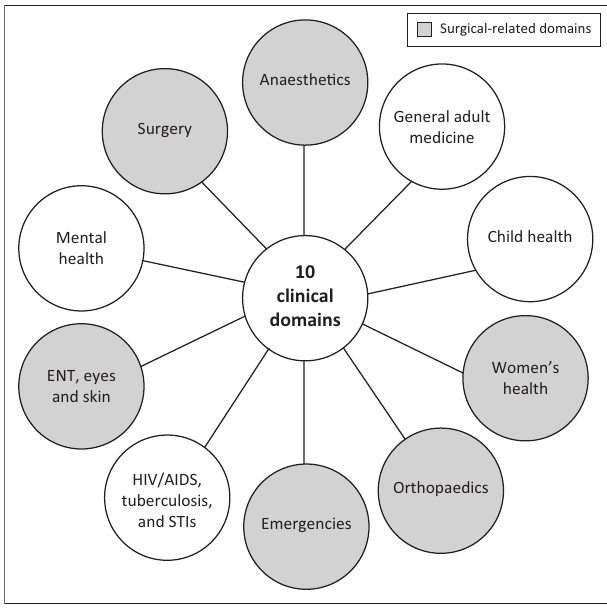
FIGURE 1: The 10 clinical domains of the family physician at the district